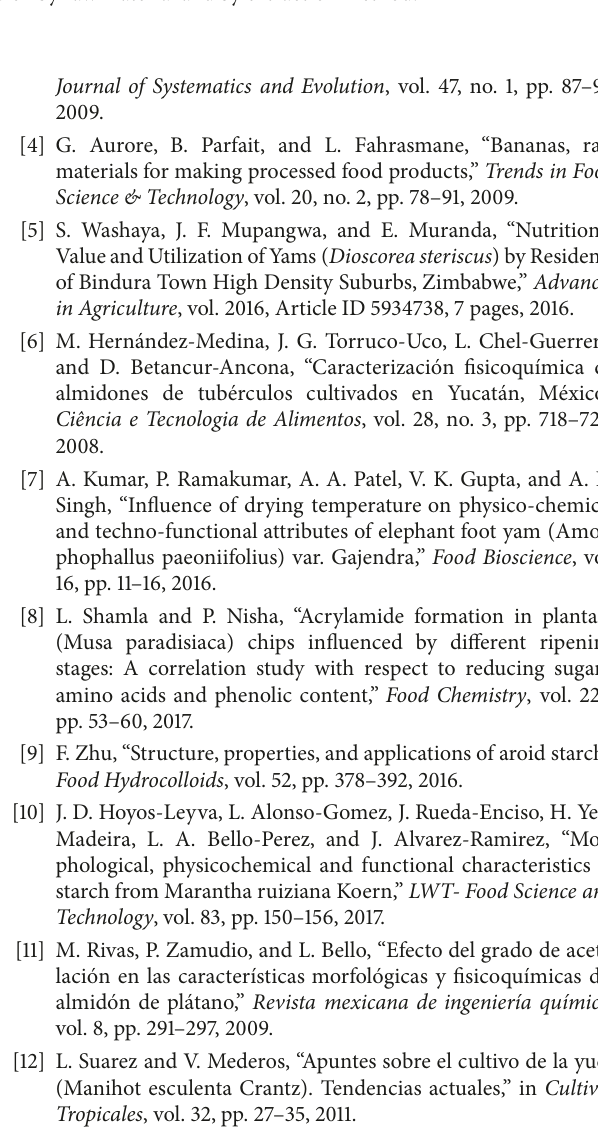
Figure 2: Average chart for the percentage of starch by raw material and by extraction